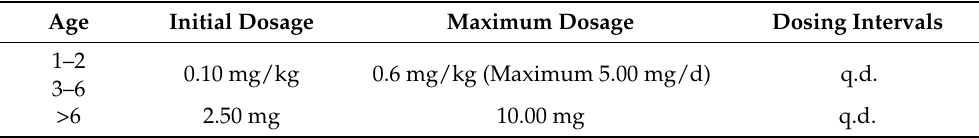
Table 3. Dosage recommendations of amlodipine for antihypertensive drug treatments in outpatient hypertensive patients